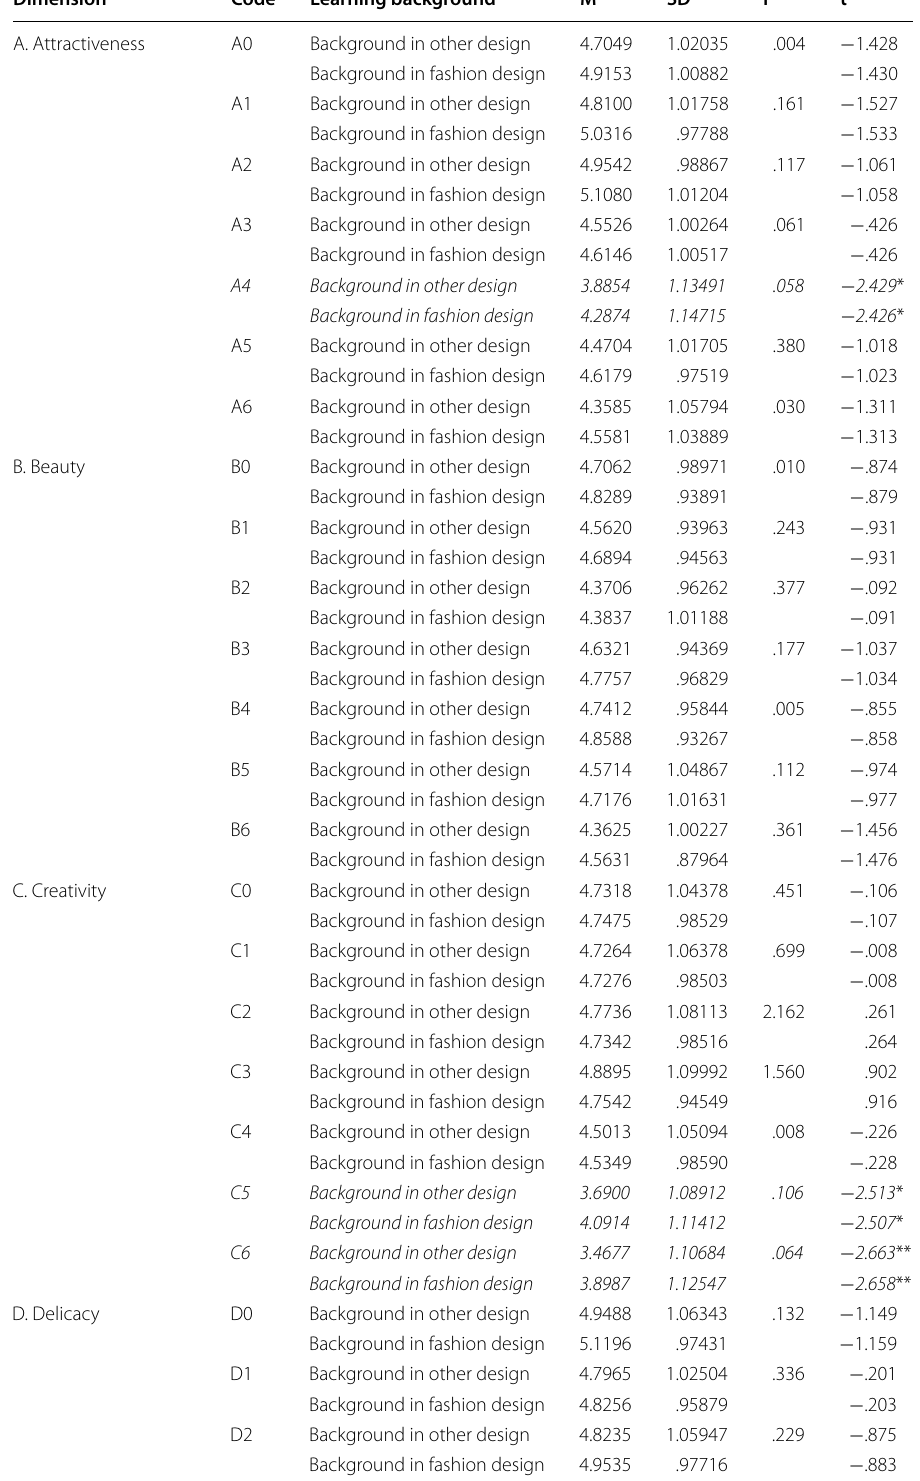
Table 6 T test of dimensions of the questionnaire of different learning background (N 192) =